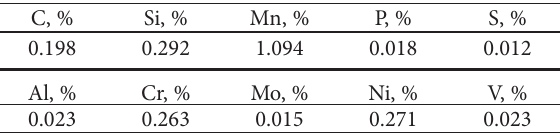
Table 5. Chemical composition of material for the automatic coupler